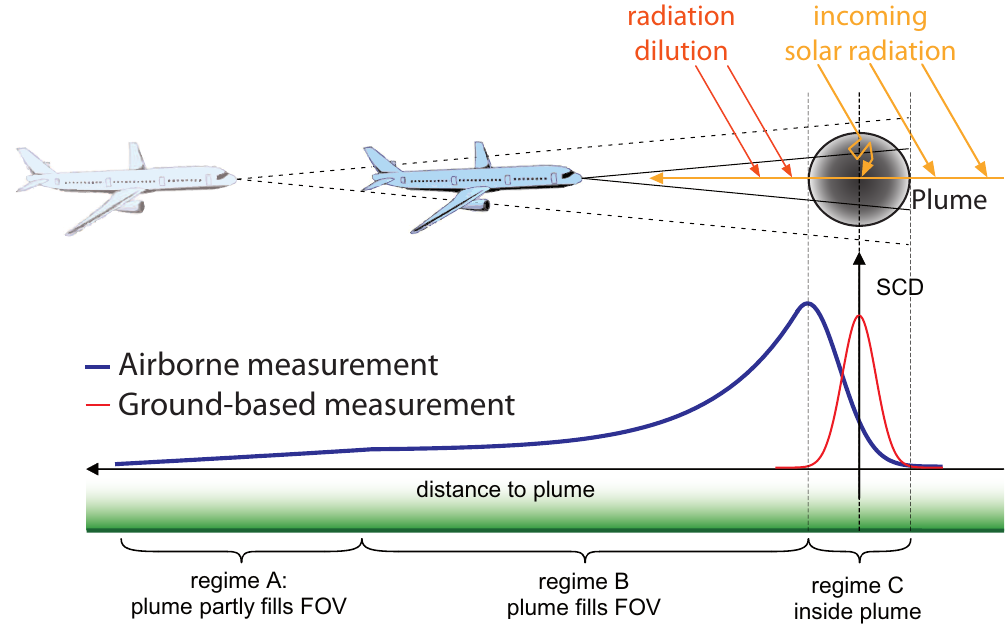
Fig. 1. Upper part: sketch of observation geometry of a forward looking telescope in an aircraft approaching a volcanic plume. There are three regimes: A – the plume only partly fills the field of view (FOV) of the instrument, B – the plume completely fills the FOV, C – the